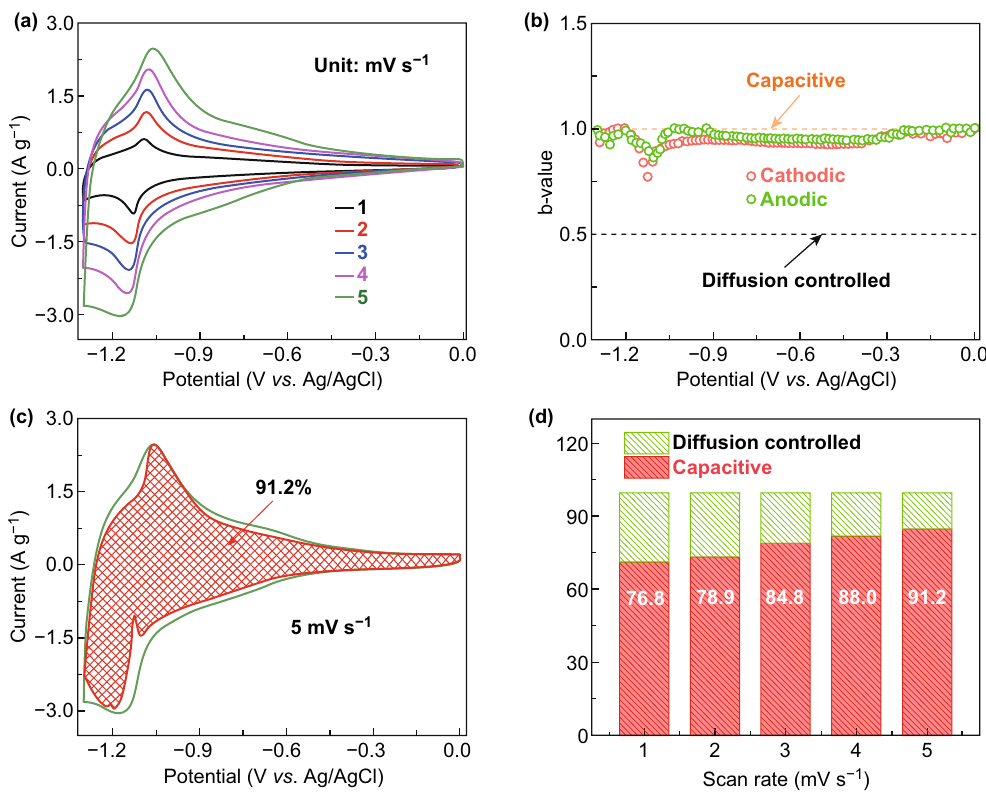
Fig. 4 Kinetic analysis of NbWO electrode. a CV curves at various scan rates from 1 to 5 mV s −1 . b Determination of the b -values at various potential. Contribution of the capacitive behavior at 5 mV s −1 ( c ) and 1 to 5 mV s −1 ( d